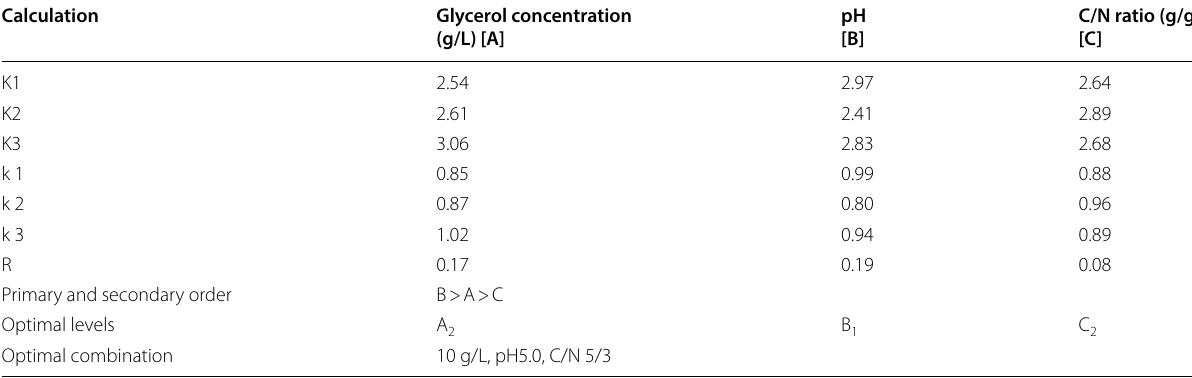
Table 7 The results of analysis of orthogonal experimental design Calculation